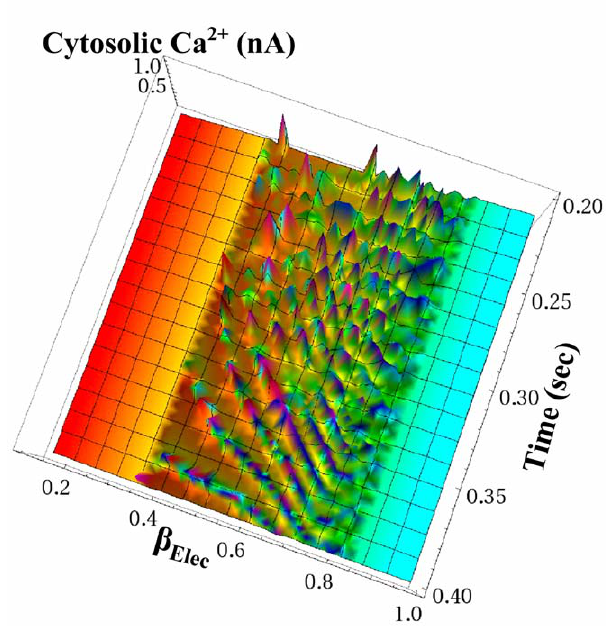
Figure 14. Three-dimensional representation of the cytosolic Ca 2 + oscillations based on the ideal electrical model equations for the m ~ n ~ 2, p ~ 4 case. Using parametric sweep analysis with respect to the b Elec parameter, the birth and the decay of the I OUT current oscillations that corresponds to cytosolic Ca 2 z oscillations is presented. As expected, oscillations occurred only when 0 : 3 v b Elec v 0 : 8 . However, as Figure 12 illustrates, the real circuit implementing this category of Ca 2 z oscillations presented slight deviations regarding the boundaries where oscillations occurred, due to the non-ideal behaviour of the circuit’s components.